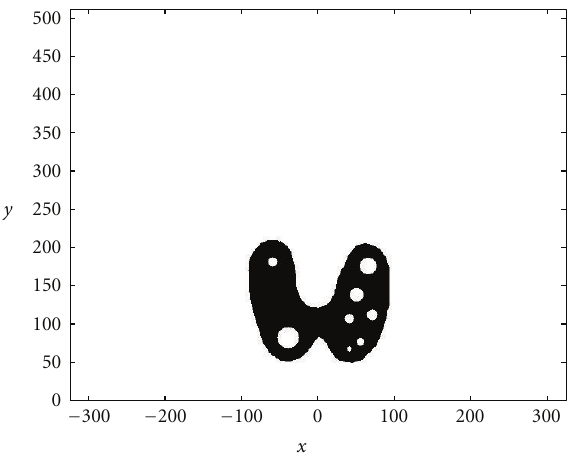
Figure 17: Compounded V-Line projection.